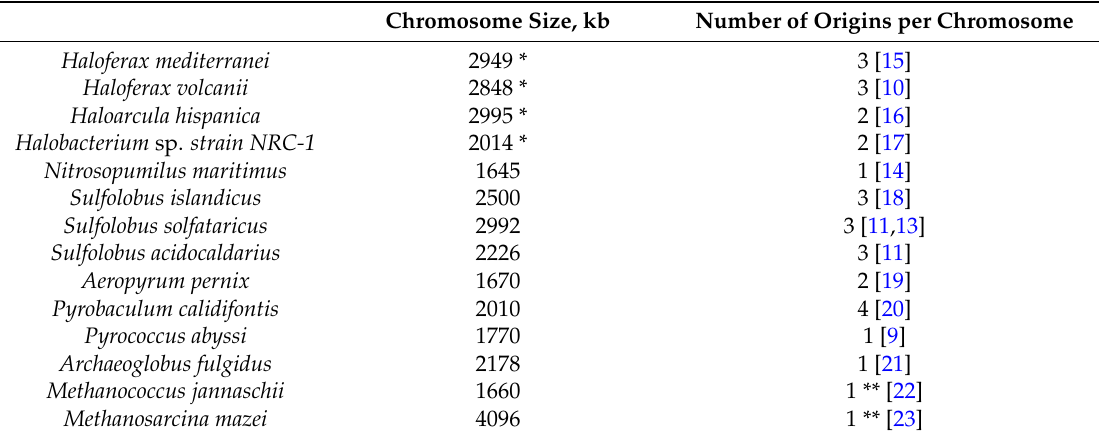
Table 1. Chromosome size and number of DNA replication origins in different archaeal species. Chromosome Size, kb Number of Origins per Chromosome Haloferax